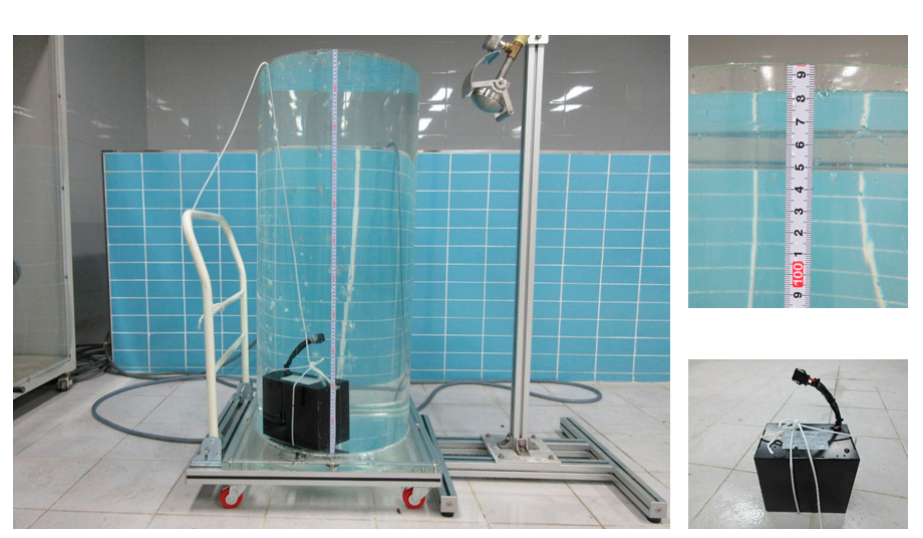
Figure 8. Lithium battery immersion test photo .